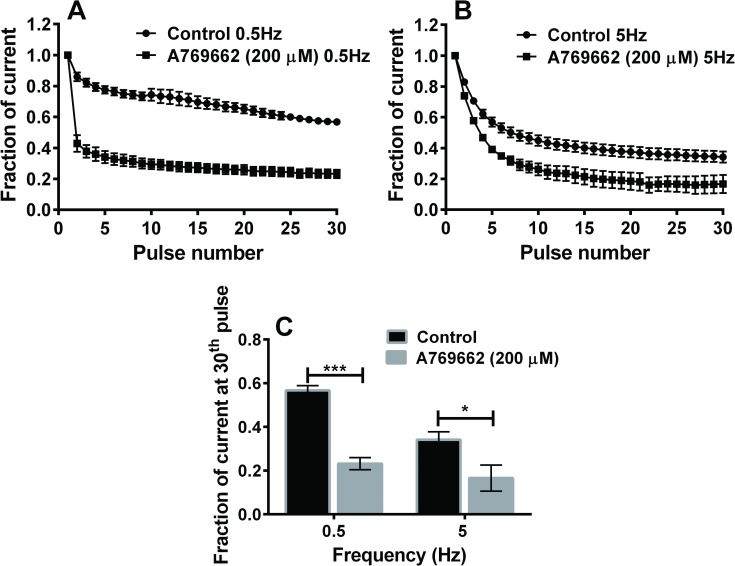
Lack of use-dependent effects of A769662 on rat TG neurons.30 repetitive 25 ms depolarizing pulses of -10 mV were applied from a holding potential of -80 mV at 0.5Hz (A) and 5Hz (B) in the absence (●) and presence (■) of A769662 (200 μM). Peak current amplitude at each pulse was normalized by the peak current amplitude of the first pulse under each condition and plotted vs the pulse number. (C) Fraction of current at the 30th depolarizing pulse at 0.5 Hz and 5 Hz in the absence and presence of A769662 (n = 5–15, two-way ANOVA, * p < 0.05, *** p <0.001).